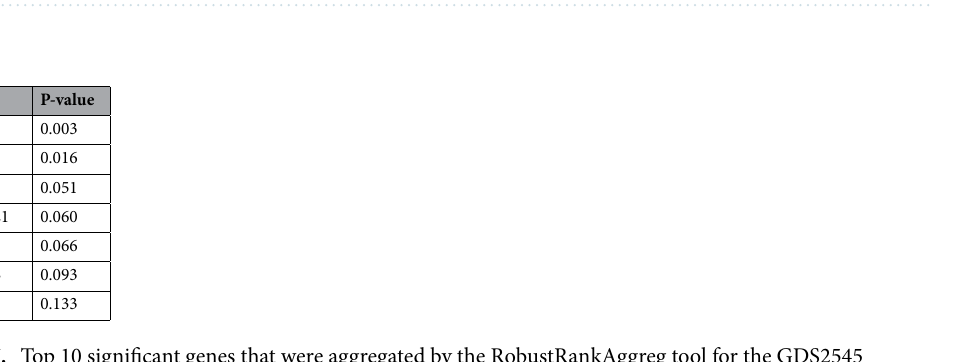
Table 6. An output of the RobustRankAggreg tool for the GDS1962.